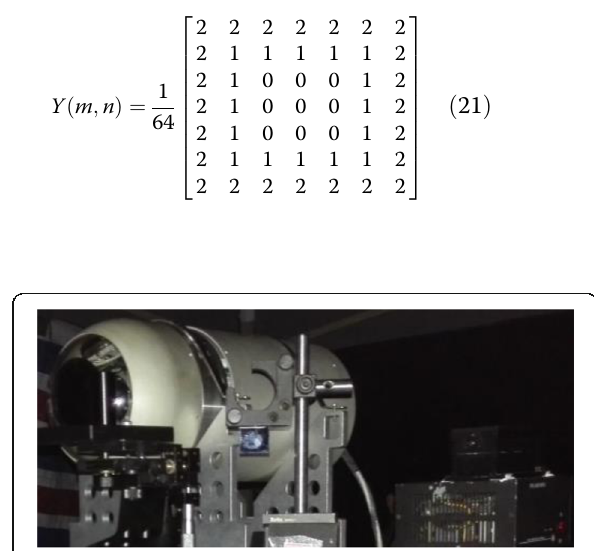
Fig. 15 Image field system based on laser active illumination